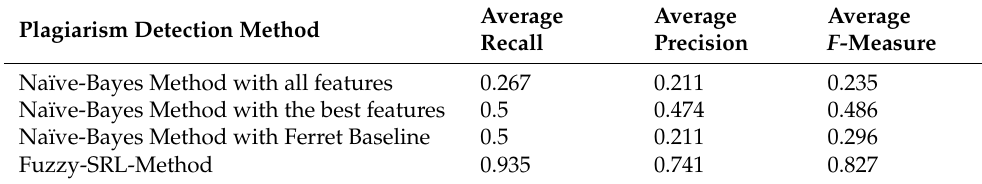
Table 6. Cut-and-paste plagiarism class.